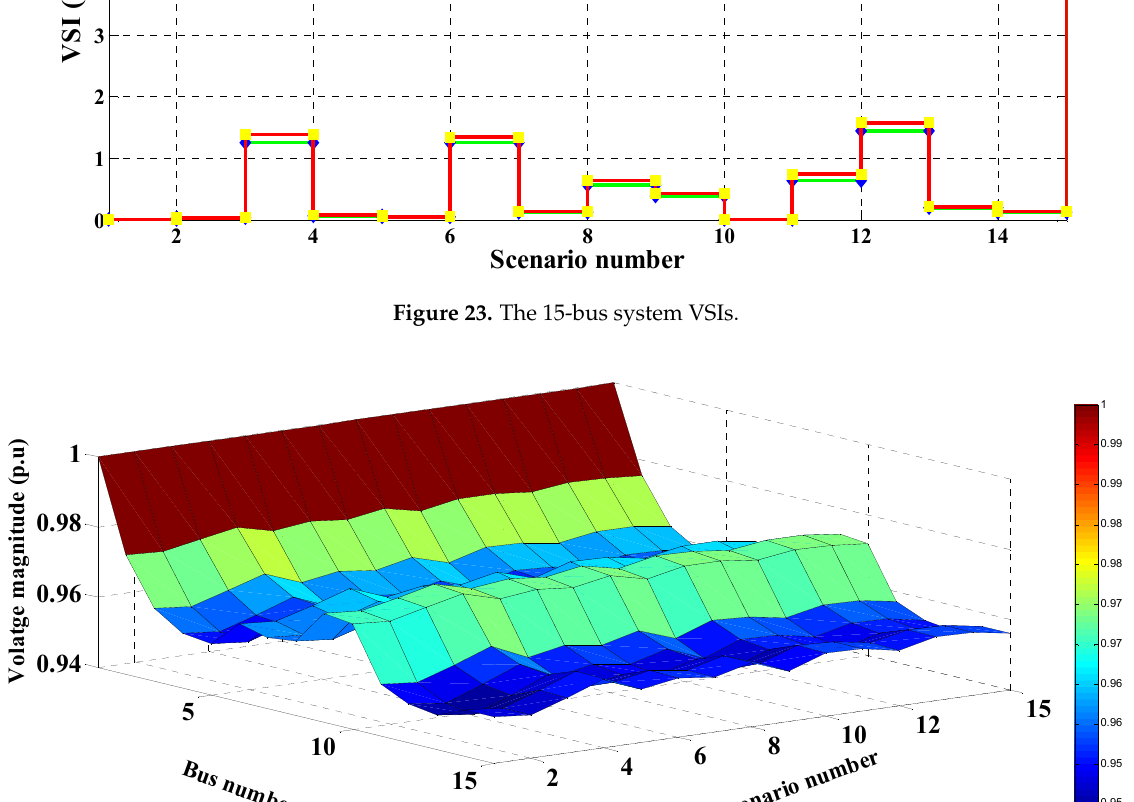
Figure 25. Bus voltage magnitudes of the 15-bus system with RERs. Table 10. The 15-bus system simulation results. Scenario